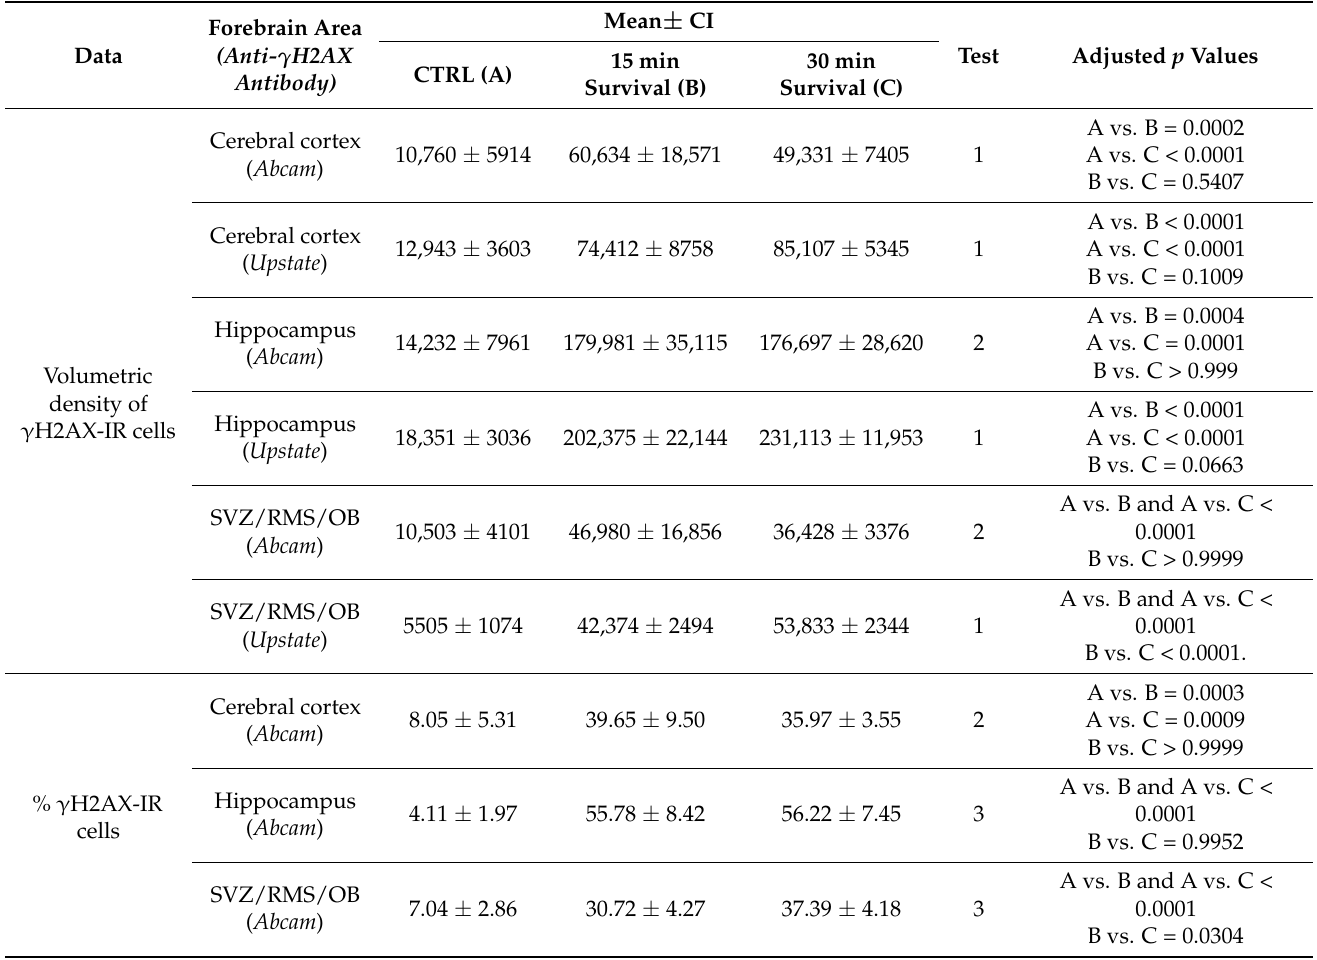
Table A1. Statistical analysis of volumetric densities and percentages of γ H2AX immunoreactive cells. Legend : 1 = Welch’s ANOVA and Dunnett’s T3 multiple comparison test; 2 = Kruskal-Wallis and Dunn’s multiple comparisons test; 3 = Ordinary one-way ANOVA and Tukey’s multiple comparisons test. See Figures 3 and 4 for